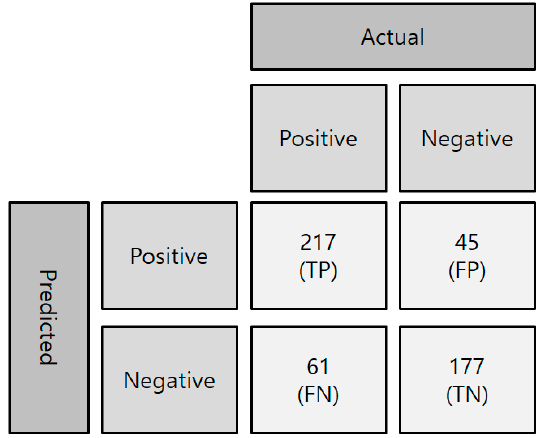
Figure 8. Confusion matrix for binary classification .